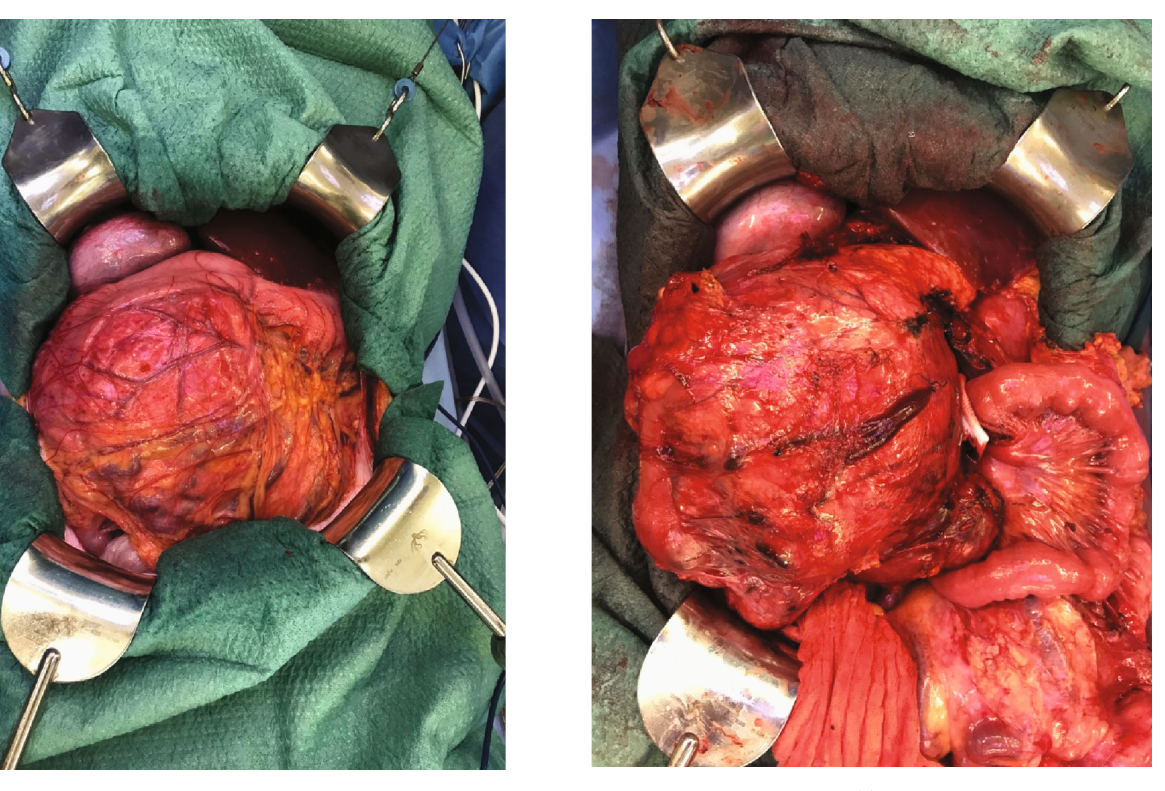
Figure 6: Tumor mass. Figure 7: Tumor